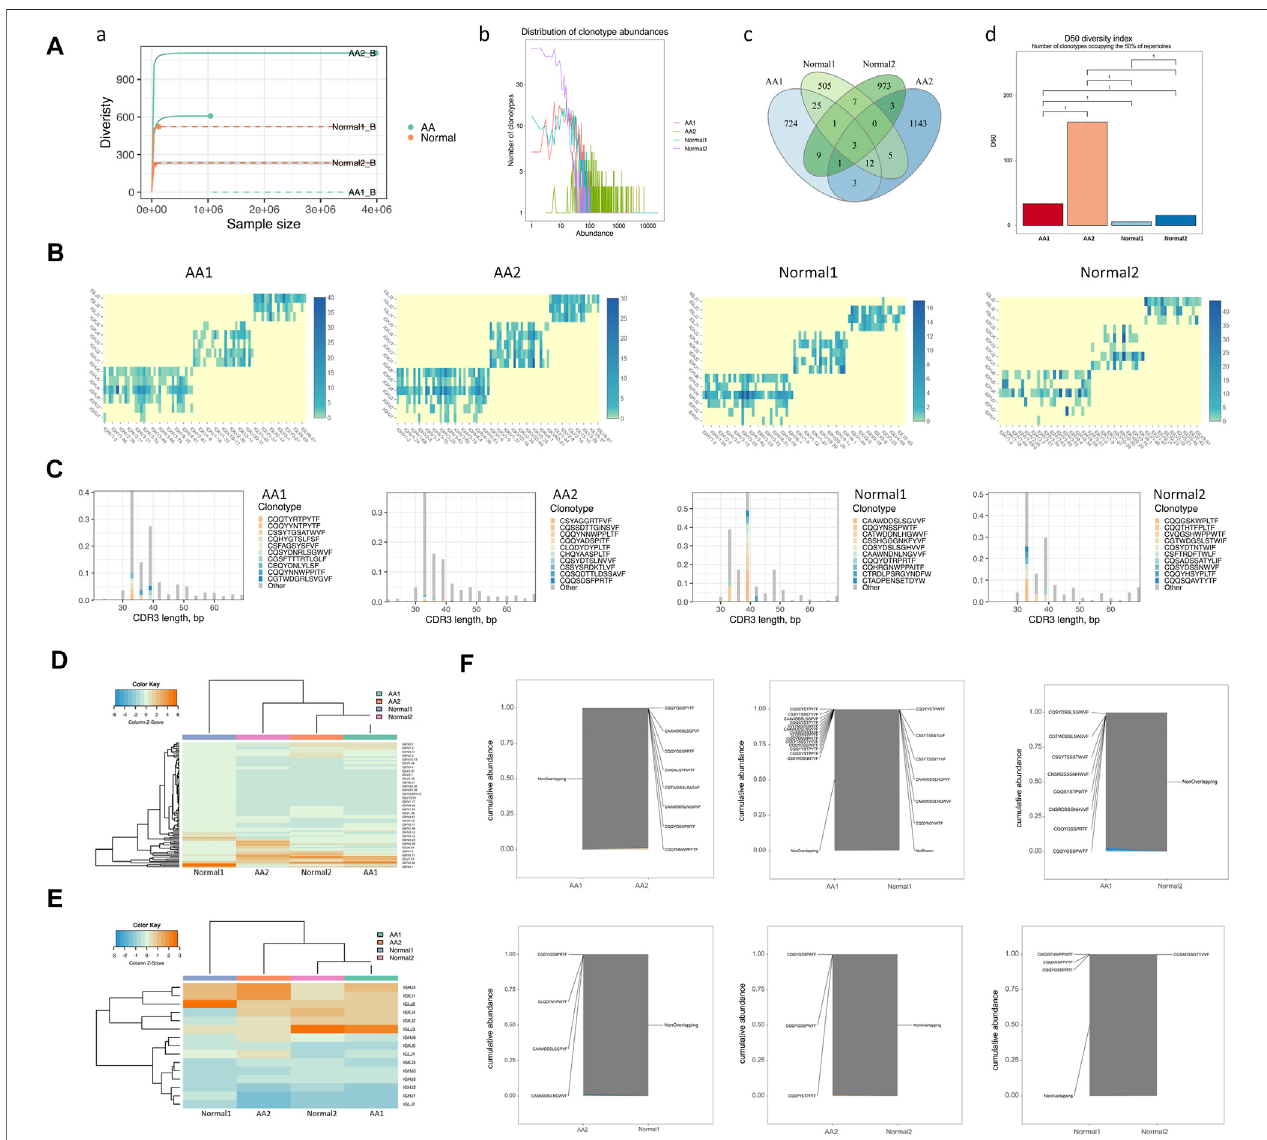
FIGURE 3 | BCR diversities and pairing frequencies of V and J genes. (A) BCR diversities, including sample dilution curve (a), rank abundance curve of BCRs (b), venn diagram of BCRs (c), and the D50 index of BCR diversity (d). (B) Heatmap depicting V – J gene pair use frequency (C) Distribution map of V gene composition with the length distribution of CDR3 amino acid sequences. (D) Heatmap of the V gene. (E) Heatmap of the J gene. (F) Coincidence comparison of immune group libraries.